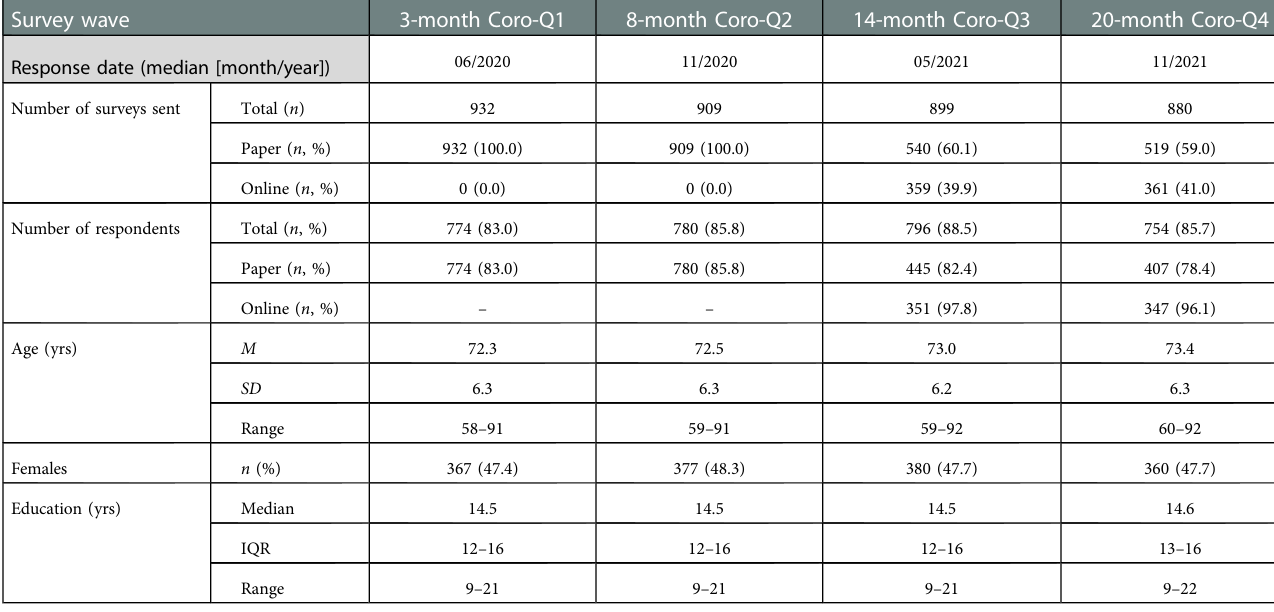
TABLE 1 Peri-pandemic timing of survey waves and demographic characteristics of respondents. . Survey wave 3-month Coro-Q1 8-month Coro-Q2 14-month Coro-Q3 20-month